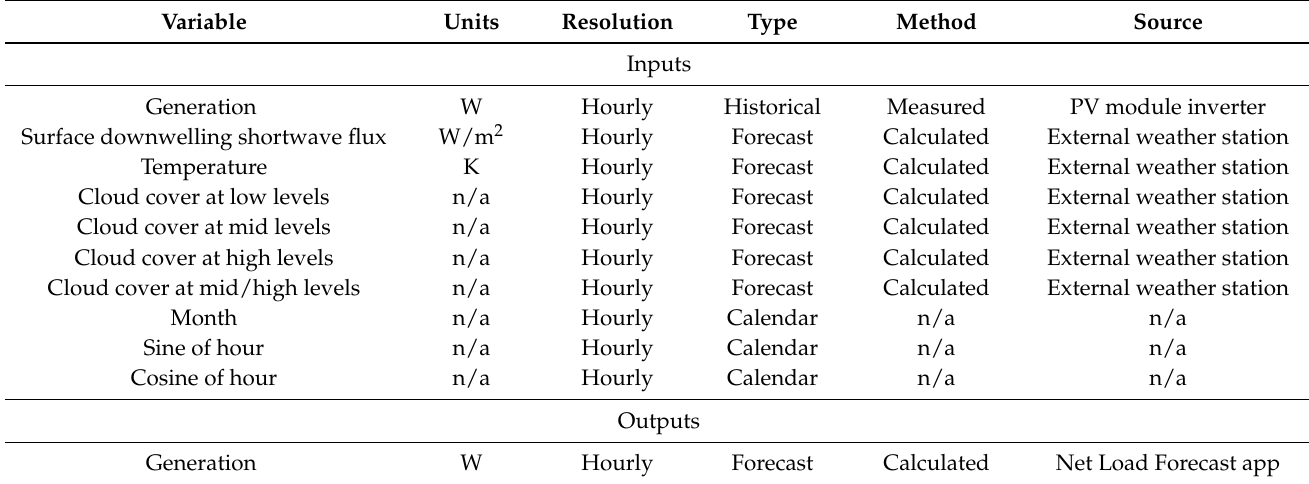
Table 3. Detailed list of inputs and outputs for PV Forecast in the Net Load Forecast application.